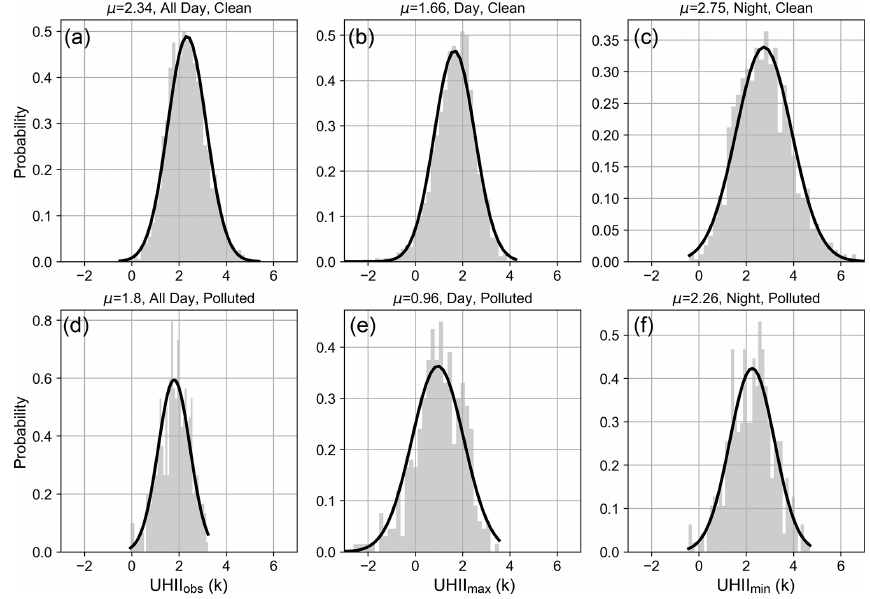
Figure 1. Probability distribution of UHII obs (a, d) , UHII max (b, e) and UHII min (c, f) under clean (a–c) and polluted (d–f) conditions. The bold curve in each subgraph is normal distribution curve, and µ denotes the average